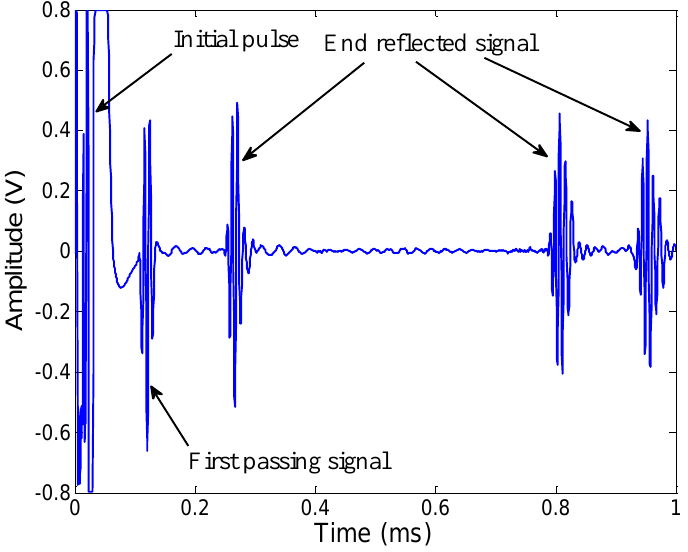
Figure 15. The typical data of the experiments on the intact pipe (pipe A) obtained at 30 A I of excitation current. pp